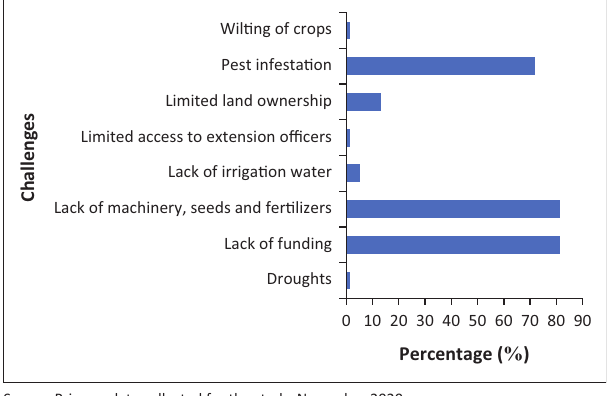
FIGURE 3: Challenges faced by female farmers in Thaba Chweu Local Municipality.